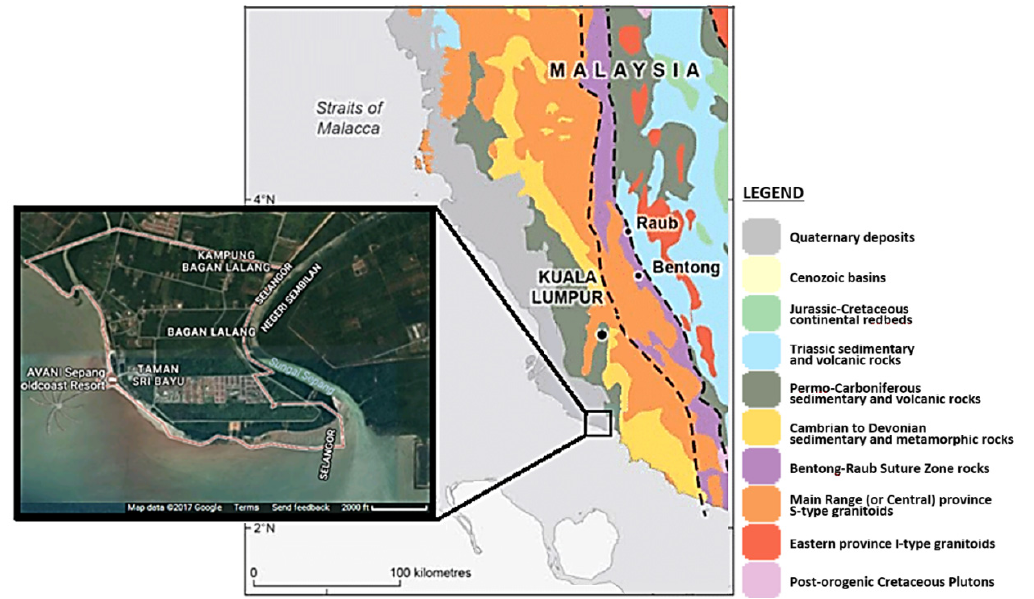
Figure 1. Bagan Lalang geological map, satellite image. The study area is bounded by the latitudes 2°, 28’-32.142”-2° 35.828’ N and longitudes 101°41.557’-101° 50’ 18.4374” E.